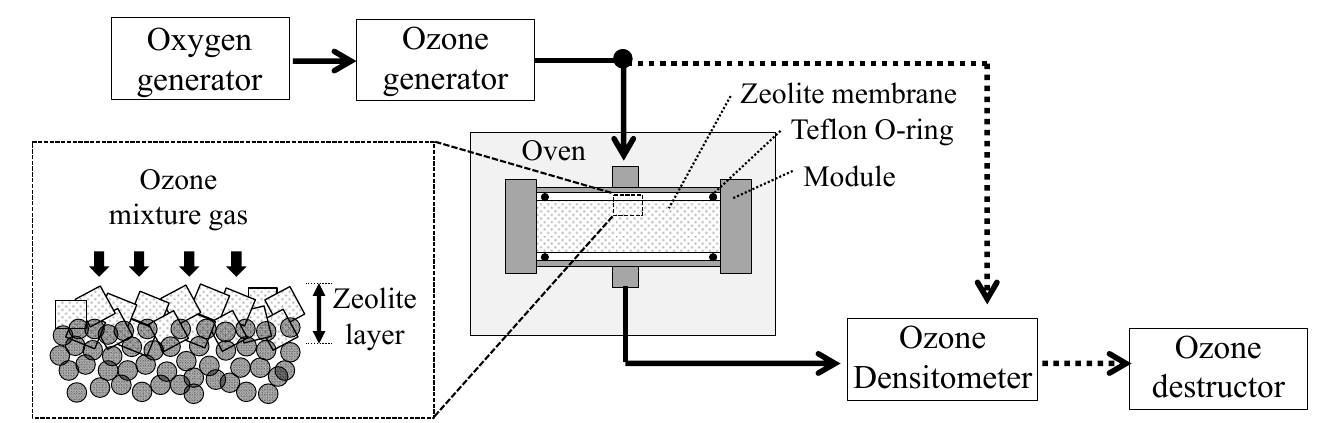
Figure 3. Schematic of the ozone detemplate apparatus.